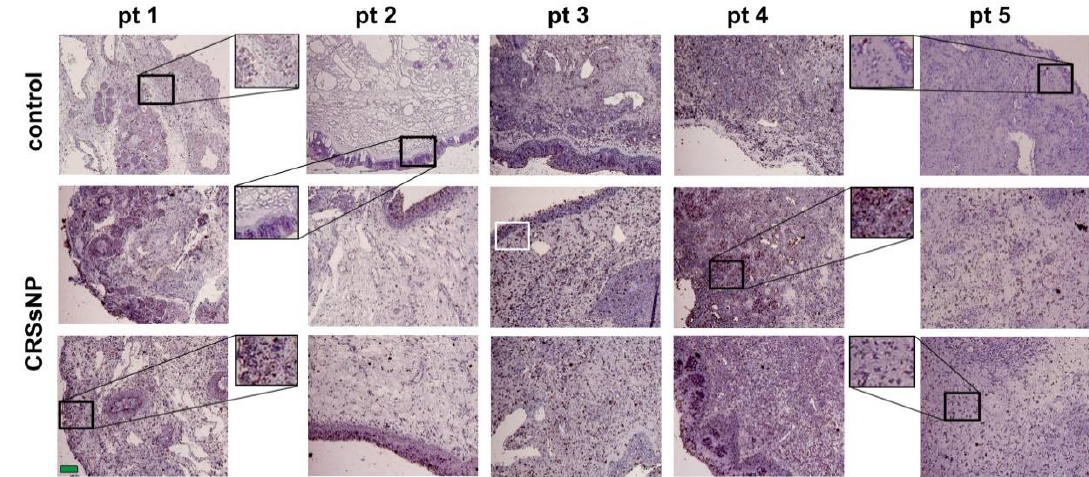
Figure 2. IHC analysis of lipid/fat deposition. The nasal mucosae were stained by Oil Red O and the dark reddish color spots indicate the presence of lipid/fat deposition. Some enlarged regions were 2 × magnified. Green scale bar = 100 μm.